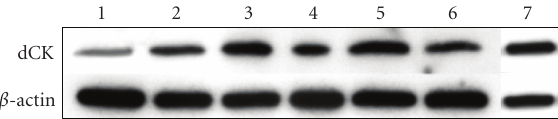
Figure 1: Expression of deoxycytidine kinase (dCK) in MM cells. With Western blot, the level of dCK was determined in several MM cell lines and compared to MOLT-4 cells-(1): Karpas, (2): LP-1, (3): MMS-1, (4): RPMI-8226, (5): 5T33MM, (6): 5T33MMvv, and (7): MOLT-4. β -actin was used as loading control; one experiment representing 3 is shown.